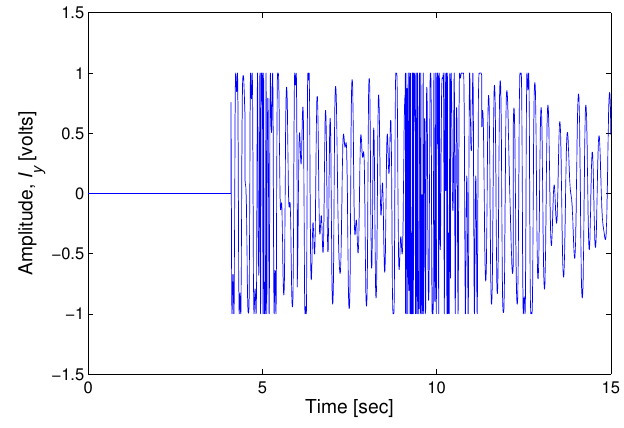
Figure 5. Intensity signal ( I y ) for spectrum analysis.